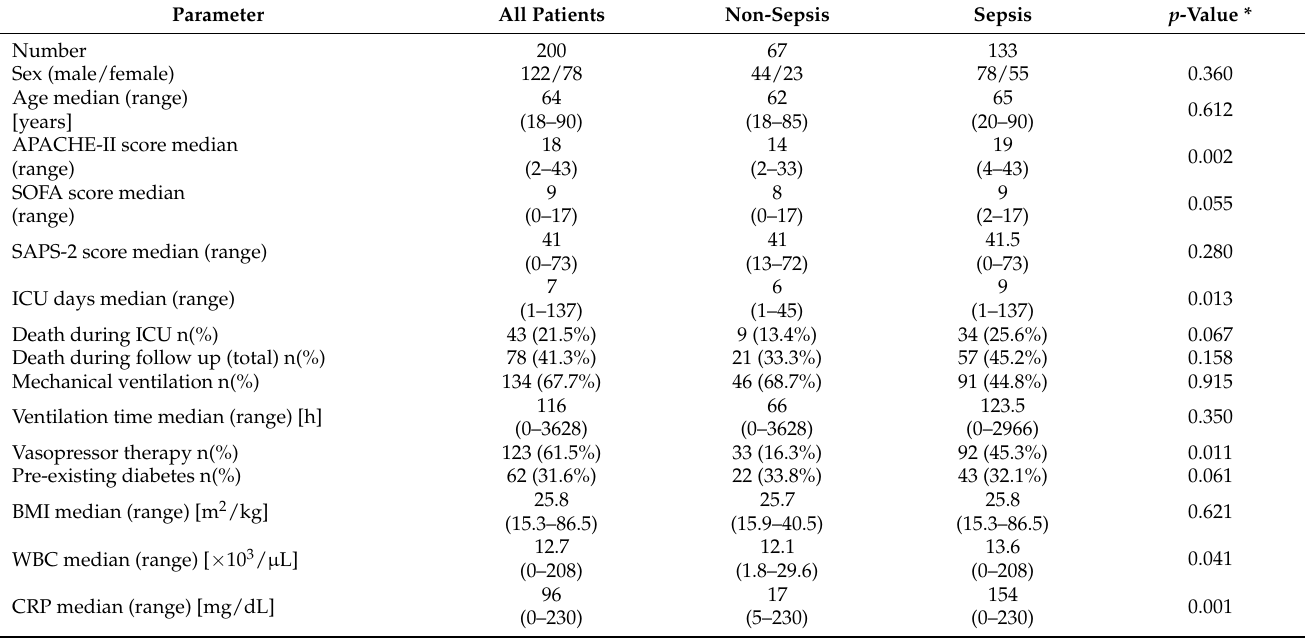
Table 1. Basic parameters and characteristics of ICU